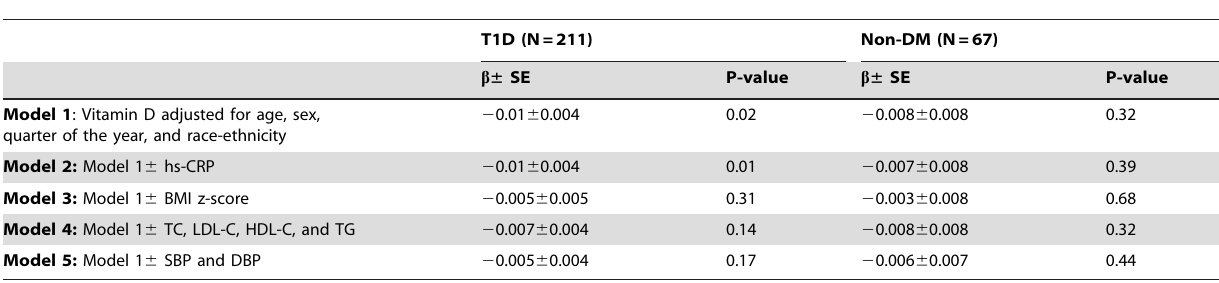
Table 3. Linear Regression Models for Vitamin D as a predictor of